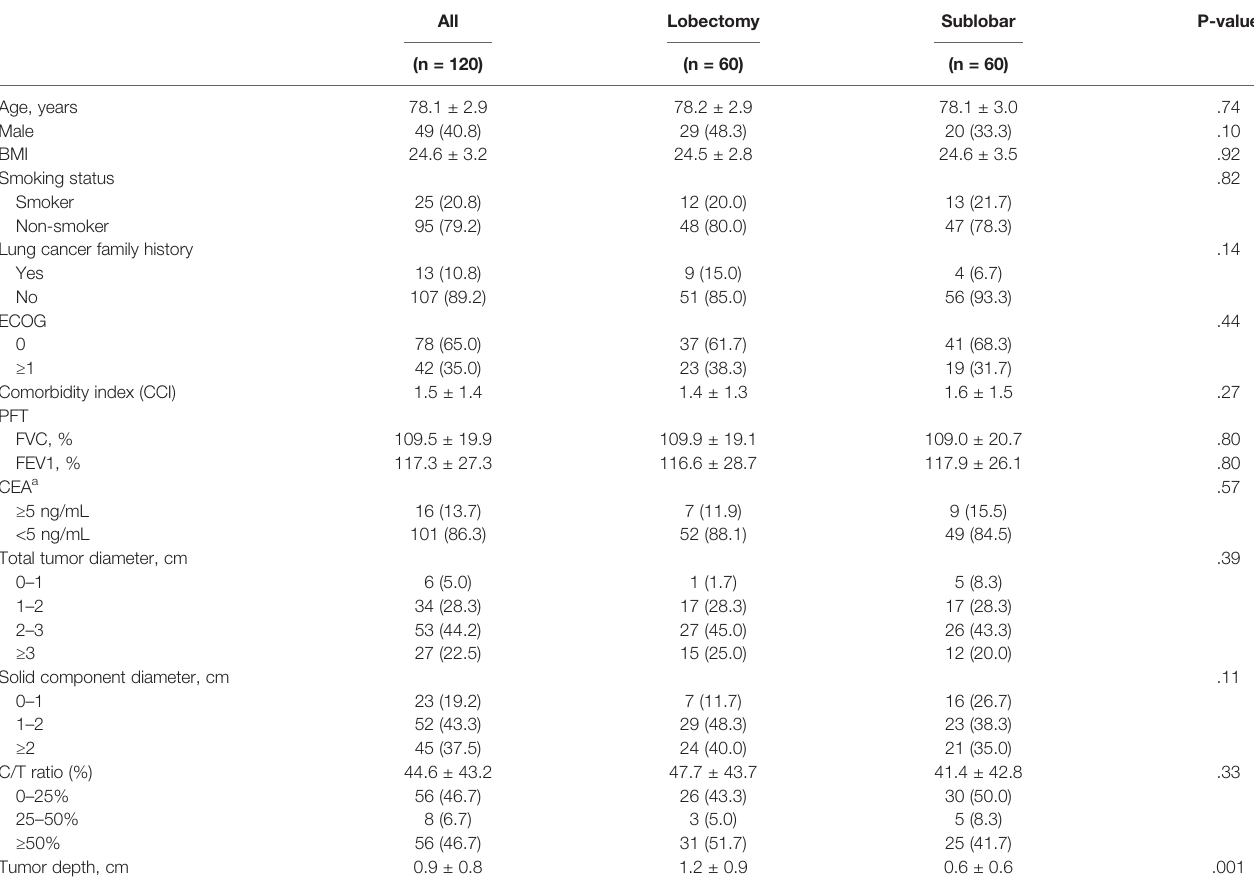
TABLE 1 | Demographic and clinical features after propensity score matching.